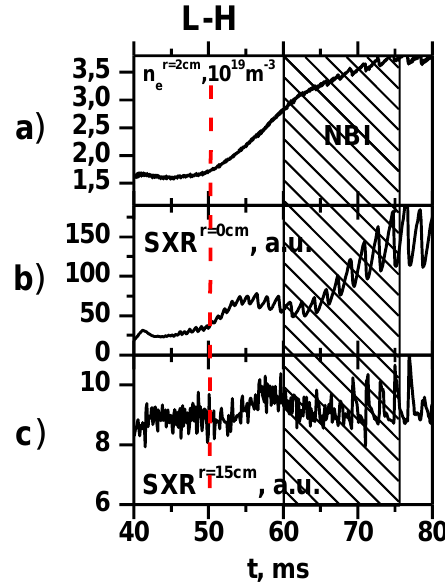
Figure 11. Plasma parameters in H-mode during NBI: ( a ) electron density n e at r = 2 cm (core region), ( b ) SXR signal at r = 0 cm (core region), ( c ) SXR signal at r = 15 cm (peripheral region). Red, dashed line at 52 ms indicates the L – H transition. NBI introduced to the plasma at 60 ms (after the transition to H-mode) is indicated by a striped box.